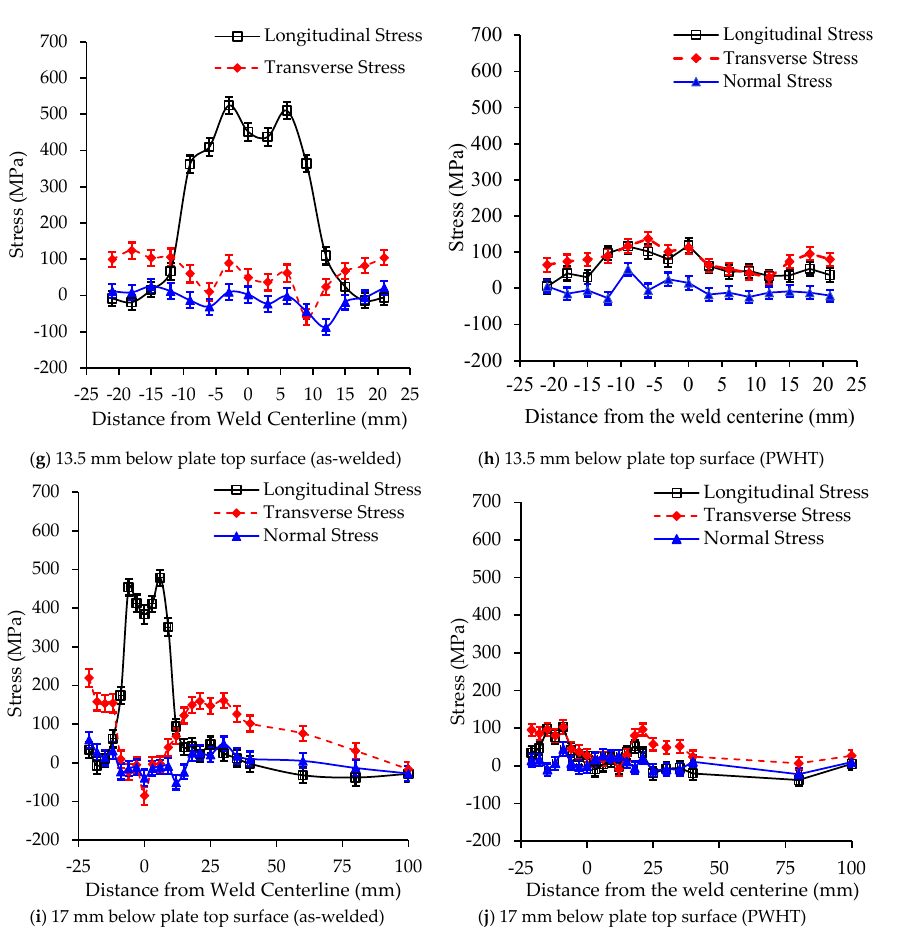
Figure 3. Longitudinal, transverse and normal residual stress distribution across the weld from 3 mm ( a , b ); ( c , d ) 6.5 mm; ( e , f ) 10 mm; ( g , h ) 13.5 mm; and ( i , j ) 17 mm, from the top surface for the as- welded and PWHT specimens.